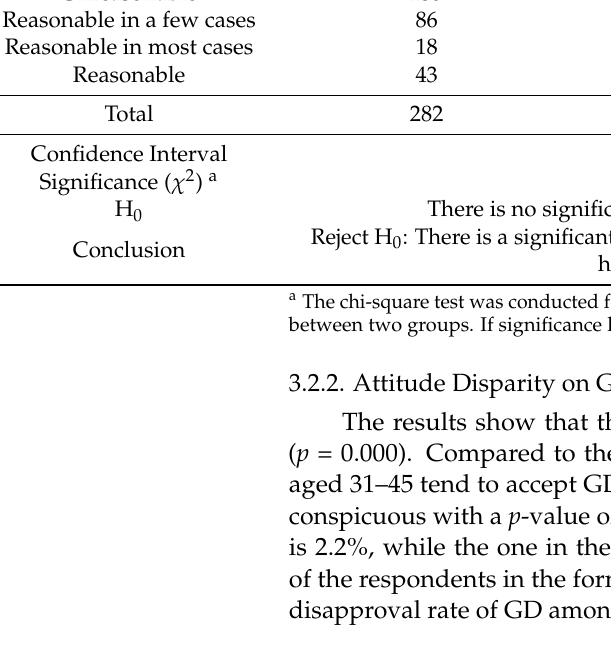
Table 4. Statistical analysis of attitude disparity on GD among different age